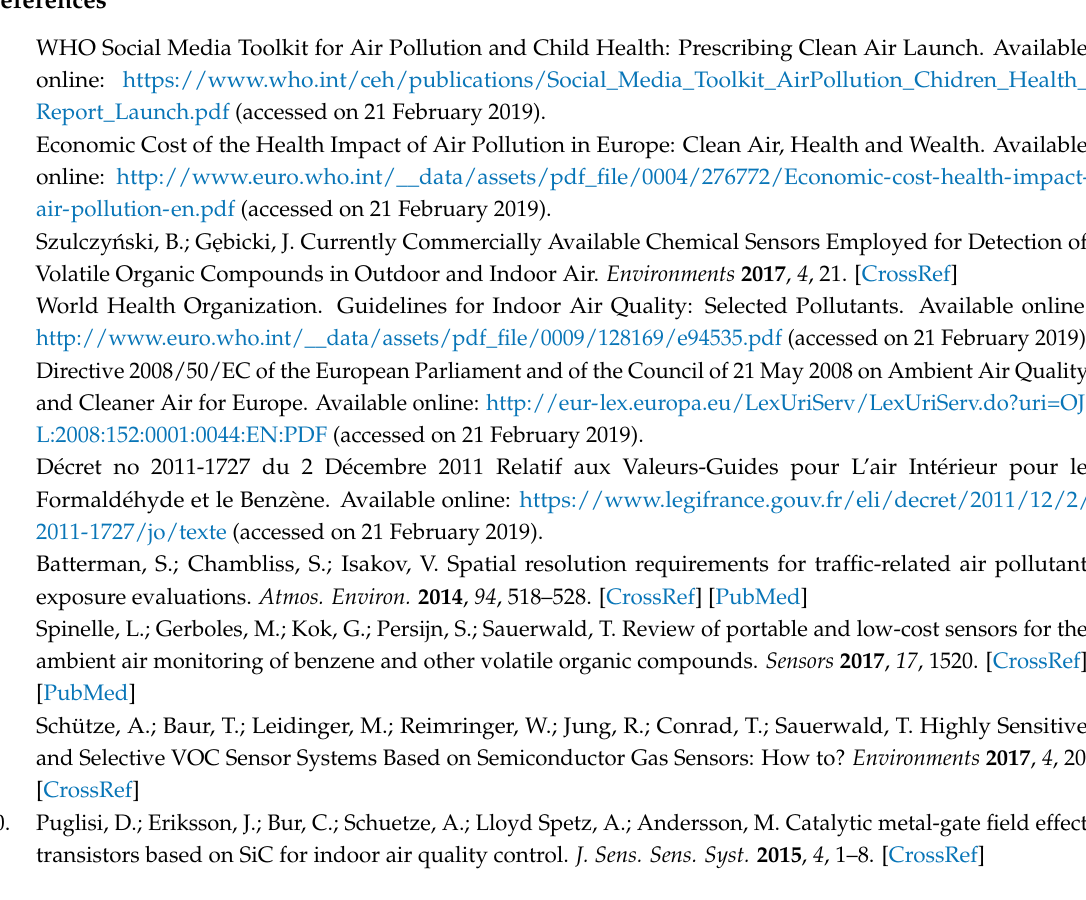
Figure S1: Reaction energy profile corresponding to benzene desorption. IS, TS and FS represent the initial state, transition state and final state,